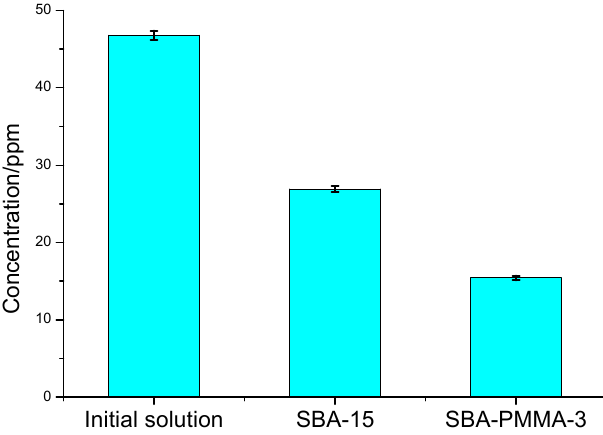
Figure 7. Adsorption abilities of SBA-15 before and after the polymer modification. Conditions: 10 mL of toluene in water solution with concentration of 47 ppm was added with 20 mg adsorbent. The mixture was stirred 24 h at ambient temperature.